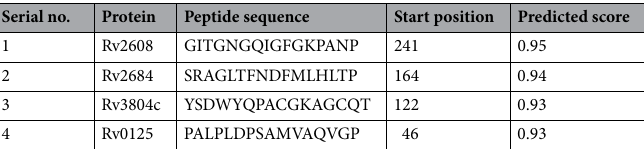
Table 3. Predicted linear B cell epitopes, a binding score greater than 0.9, are only selected for the final vaccine construct.